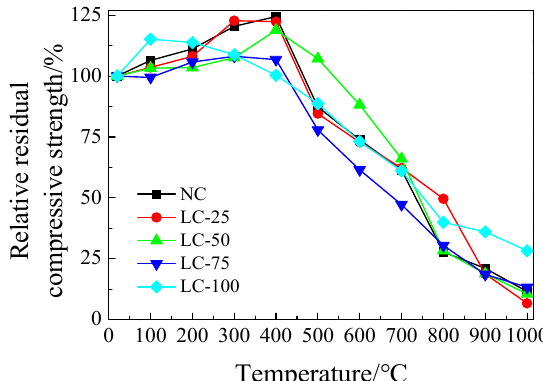
Figure 7. Relative residual compressive strength of concrete after exposure to high temperature.